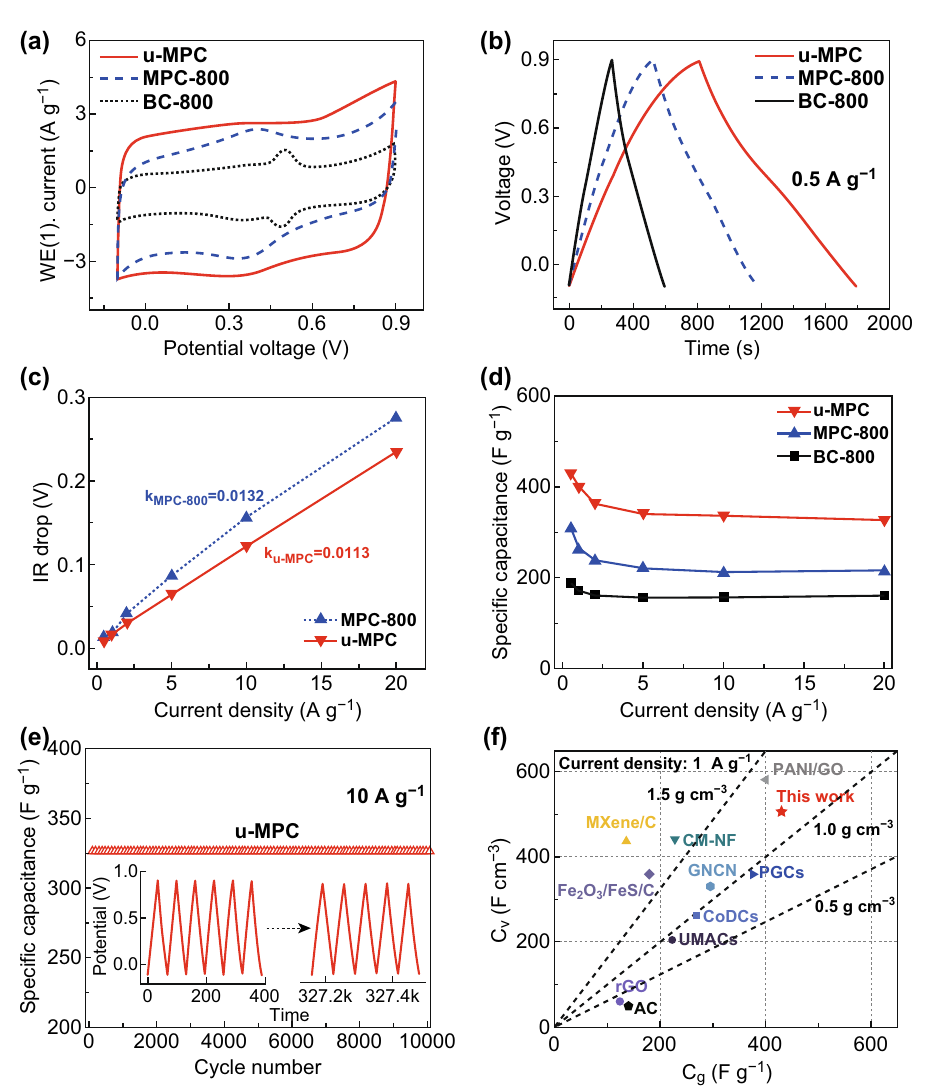
Fig. 5 Electrochemical performance of u‑MPC as compared with counterparts. a CV curves at 10 mV s −1 . b Charge/discharge curves at 0.5 A g −1 . c Plots of IR drop versus current densities. d Specific capacitance versus current density (0.5–20 A g −1 ). e Long‑term cycling perfor‑ mance at 10 A g −1 . f Volumetric and gravimetric capacitance as compared with other reported